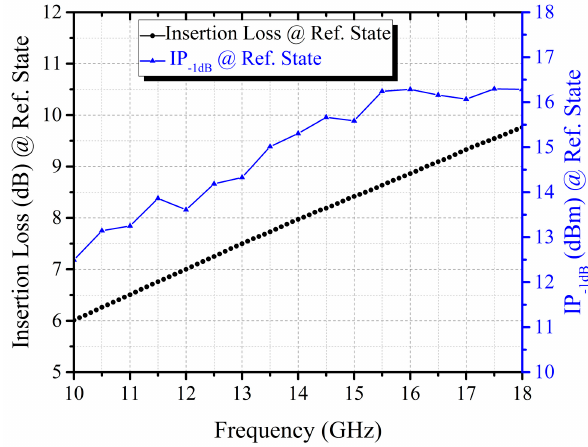
Figure 12. The measured insertion loss and IP -1dB of the proposed attenuator.